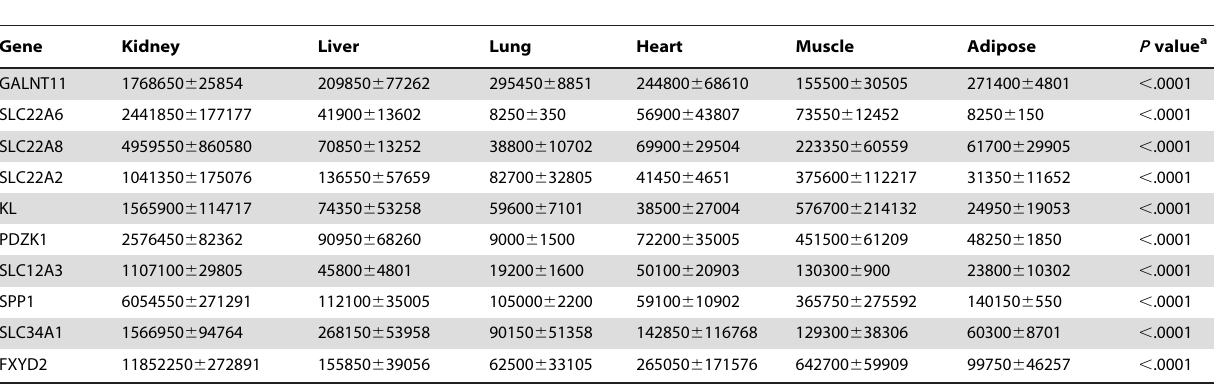
Table 2. Human kidney-specific gene expression